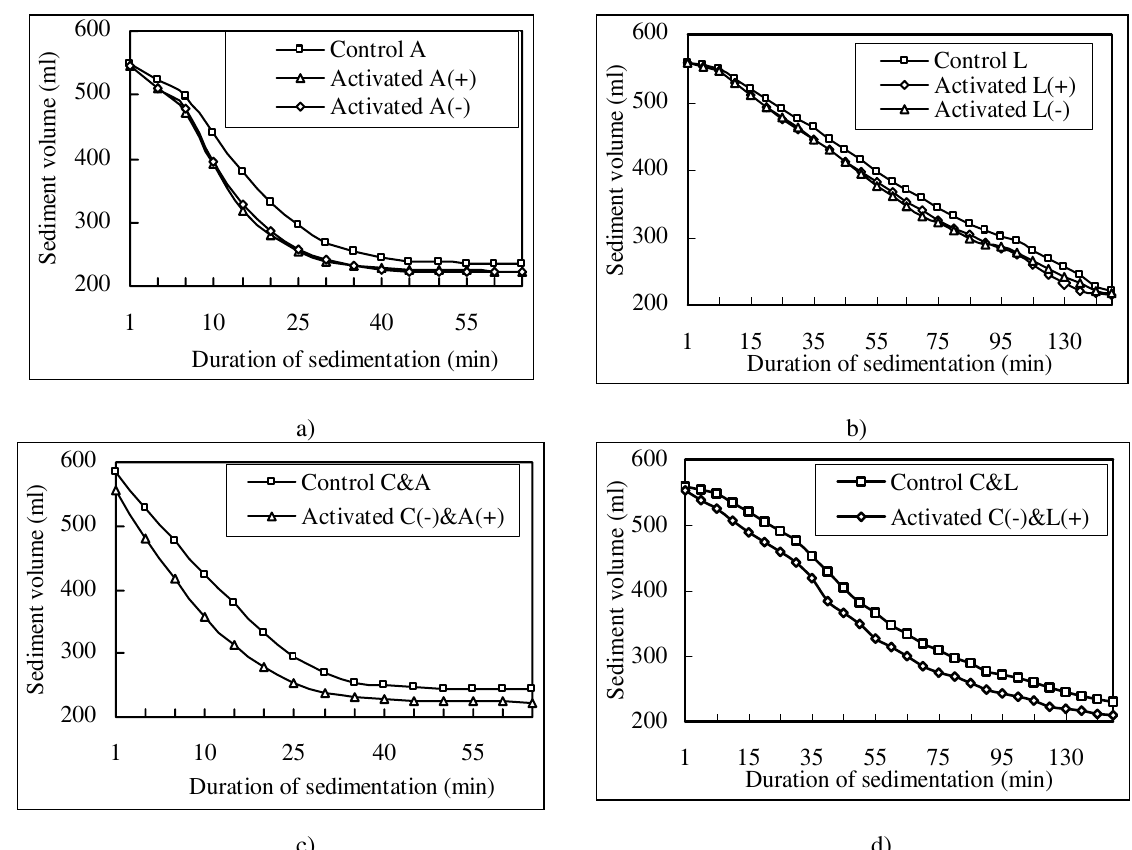
Fig 5. Kinetic of sedimentation of mineral dispersed system (C – cement, A – ash, L – limestone, (+) – activation in positive corona field, (–) – the same in negative corona field)